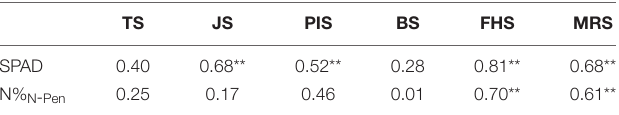
TABLE 5 | Pearson’s correlation coefficients for the correlation of Normalized Difference Red Edge (NDRE) index (based on ASD) with SPAD and N% N - Pen at different growth